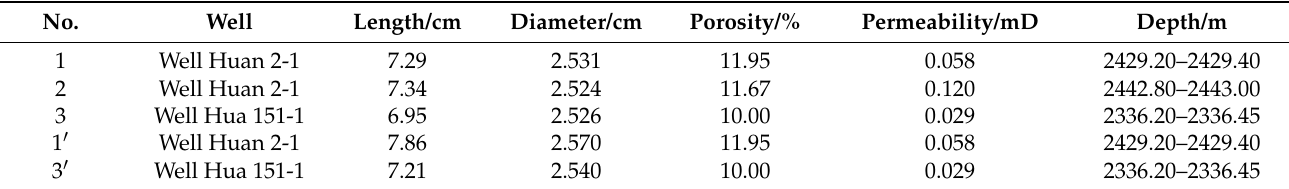
Table 1. Basic parameters of rock samples.